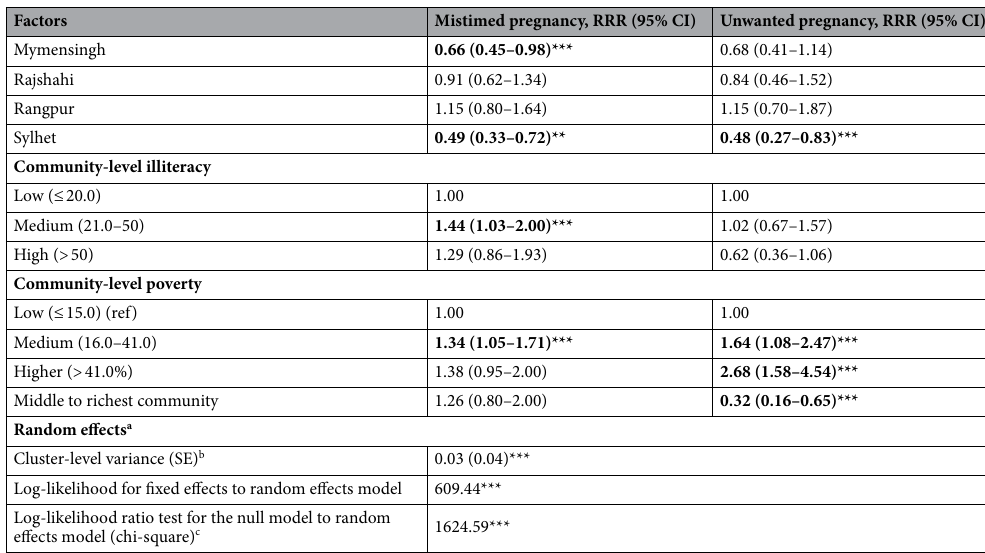
Table 3. Multi-level logistic regression modelling of unintended pregnancy and health facility level factors adjusting for individual, household/family, and community-level factors, Bangladesh, 2017/18 (N = 5051). a We assume that the within cluster-level random effects are equal for the ‘mistimed’ and ‘unwanted pregnancy’; therefore, only between cluster-level variance estimates are reported. b Significance of random effects evaluated by comparing the model with a similar one in which random effects were constrained to zero. c Compared to the null model with no-covariates. *** p < 0.01, ** p <